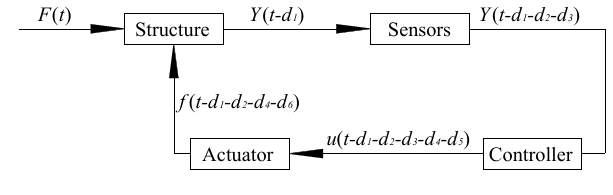
Figure 1. The model of a control system.